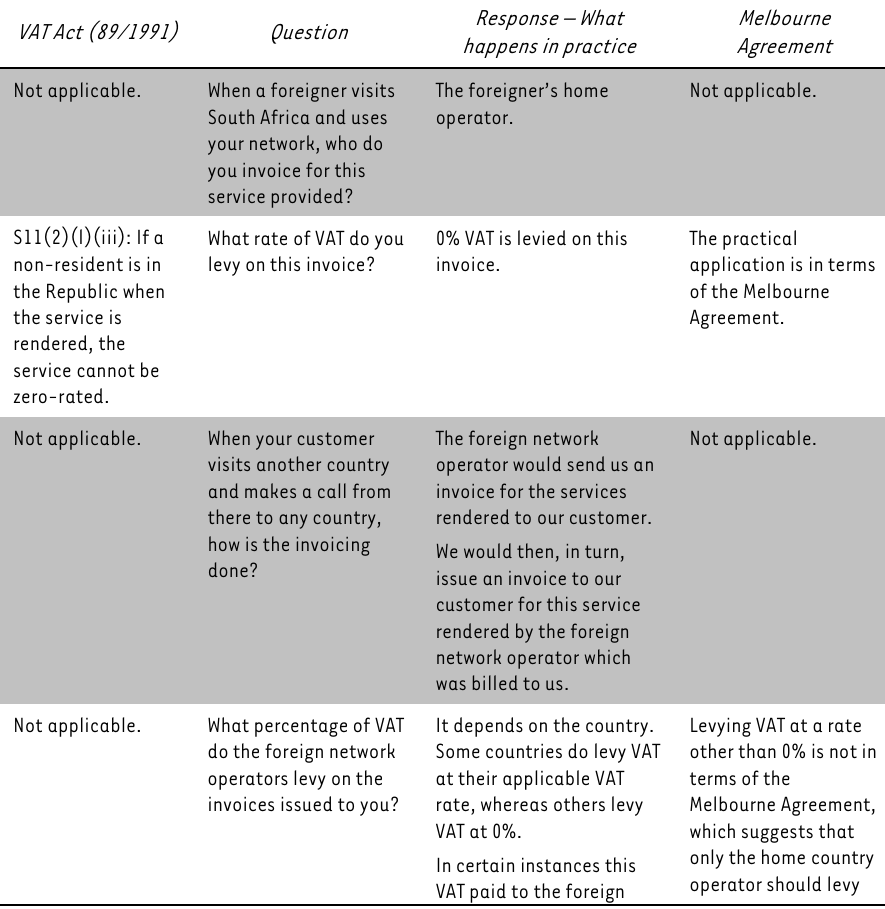
Summary of questions and responses by tax managers of telecommunication